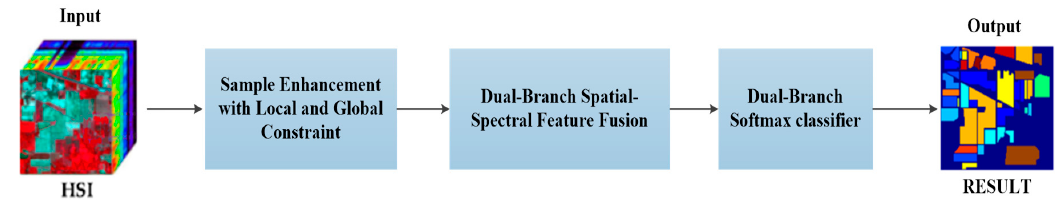
Figure 1. Flowchart of the proposed dual-branch extraction and classification method (DBECM). HSI: hyperspectral images.